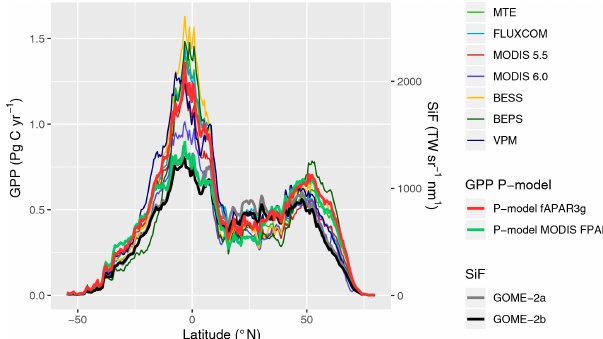
Figure 11. Latitudinal distribution of GPP and SiF. Values shown (GPP on the left y axis; SiF on the right y axis) are grid cell area- weighted sums along 0.5 ◦ latitudinal